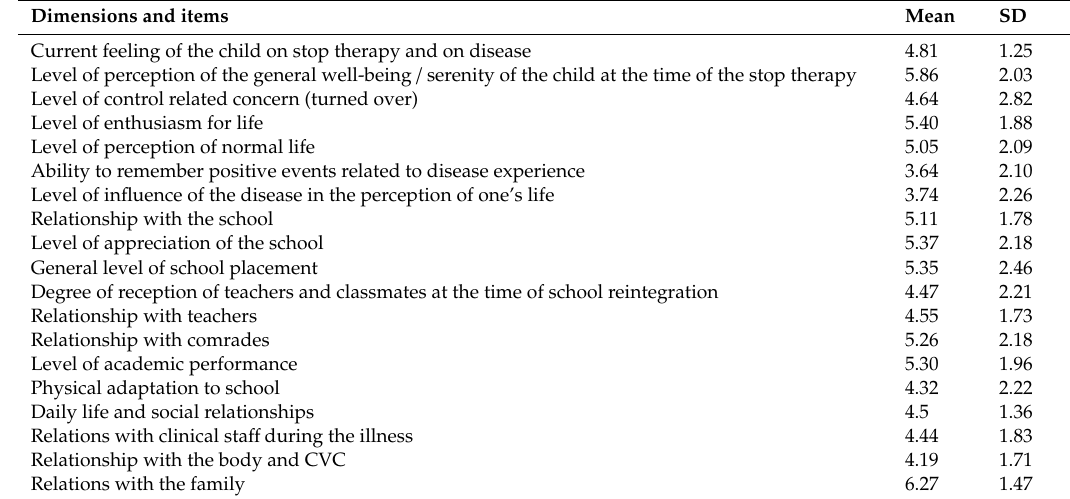
Table 4. Descriptive statistics of the dimensions of codebook referred to the child at stop